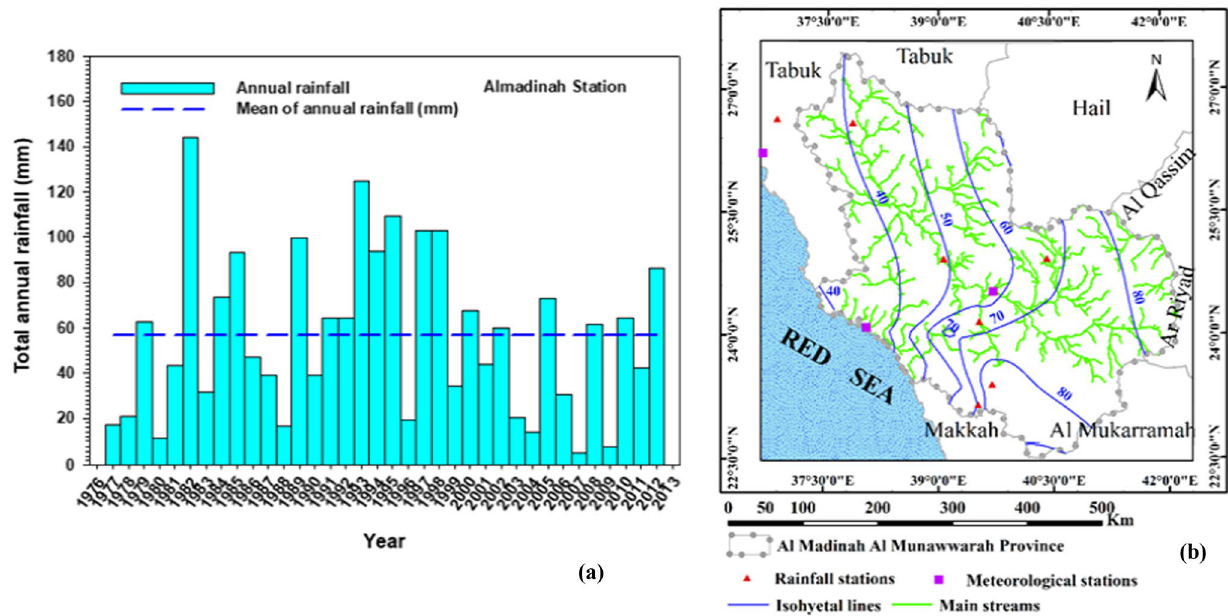
Fig. 2 Distribution of annual rainfall in the study area. a Temporal and b spatial. The rainfall stations are from the Ministry of Environment, Water, and Agriculture (MEWA). The meteorological stations (airport stations) are from the Presidency of Meteorology and Environment